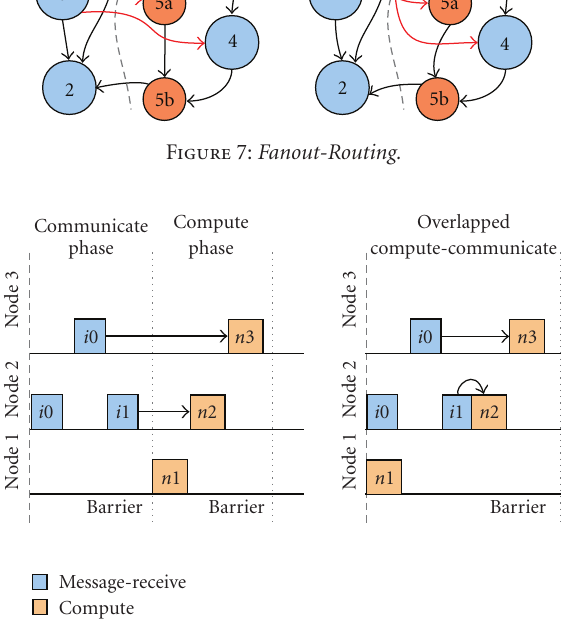
Figure 8: Fine-Grained